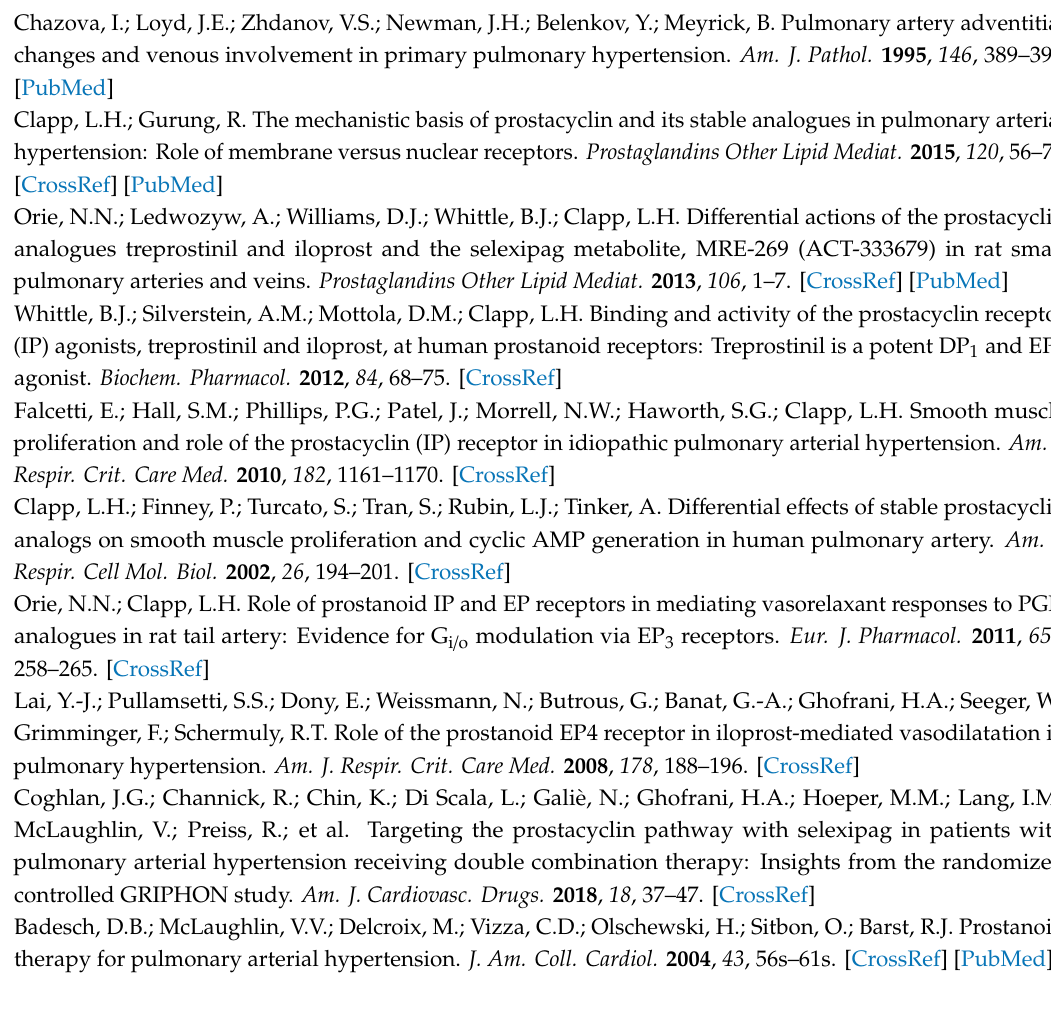
Dose analysis methods, Figure S1: Literature search results flowchart, Figure S2: Assessment of bias, Figure S3: Assessment of study quality, Table S1: Table of doses; Table S2: Table of adverse events as meta-analysed by drug type, Table S3: Odds ratios of adverse events as meta-analysed by route of administration; Table S4: Odds ratio of adverse events as meta-analysed by the treatment received in the one month up to the trial date; Table S5: Odds ratios of adverse events as meta-analysed by the concomitant therapy given during the length of the trial; Table S6: Weighted mean di ff erence of outcomes as meta-analysed by drug type; Table S7: Standardised mean di ff erence of outcomes as meta-analysed by drug type; Table S8: Standardised mean di ff erence of outcomes as meta-analysed by route of administration; Table S9: Weighted mean di ff erence of outcomes as meta-analysed by route of administration, Table S10: Odds ratios of outcomes as meta-analysed by drug type; Table S11: Odds ratios of outcomes as meta-analysed by route of administration; Table S12: Meta-regression for outcomes; Table S13: Eggers and Beggs values tests detecting publication bias on overall